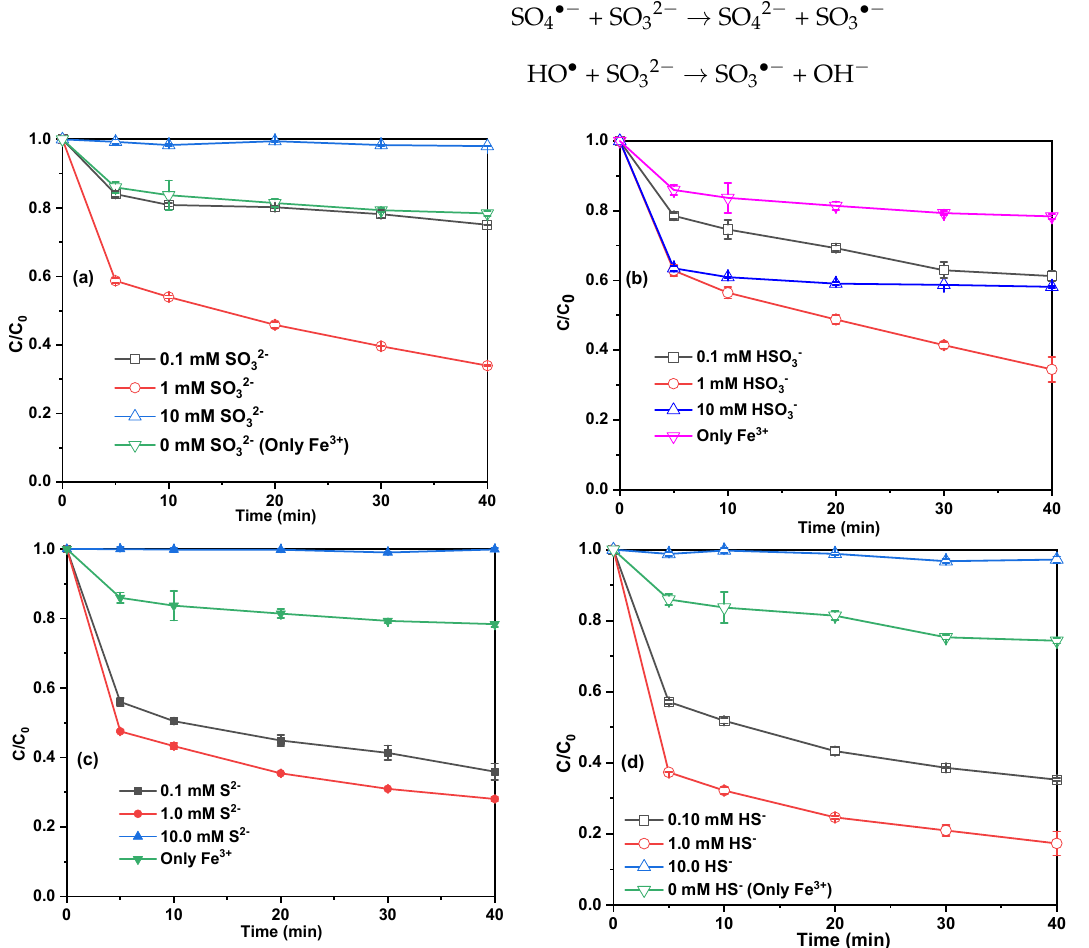
Figure 2. Effect of SO 32− ( a ); HSO 3− ( b ); S 2− ( c ) and HS − ( d ) on the removal efficiency of BPA. Reaction conditions: [Fe( Ⅲ )] = 1.0 mM, [PS] = 4 mM, [BPA] = 10.0 mg/L.